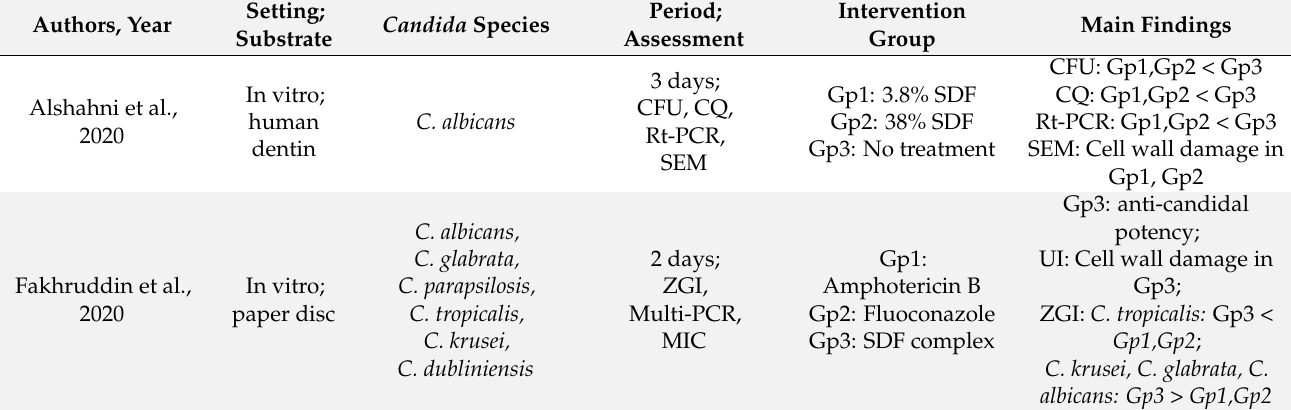
Table 3. Studies on the antifungal effect of silver diamine